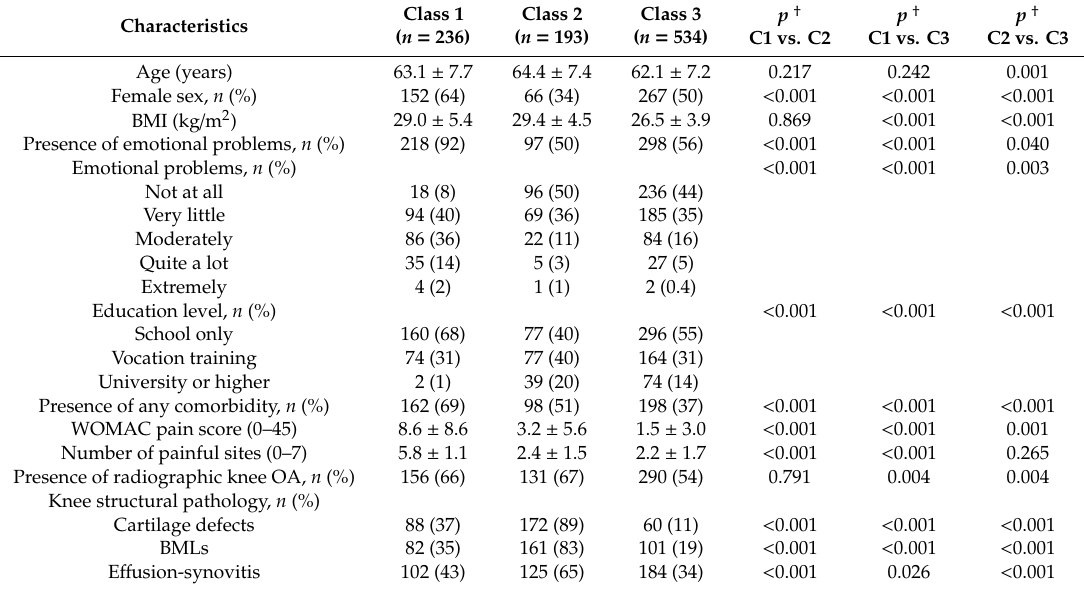
Figure 1. Flow chart of participants included in this study. Table 1. Participants’ characteristics at baseline by pain phenotypes